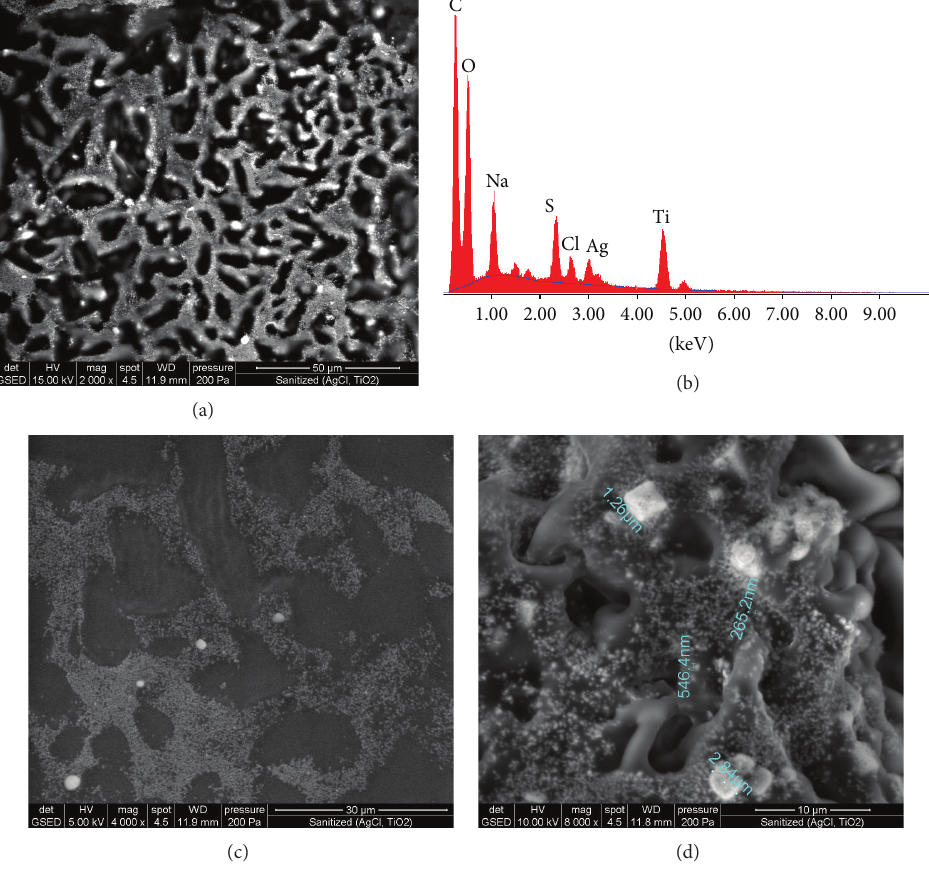
Figure 1: SEM and EDAX images for colloidal solution of silver chloride and titanium dioxide sanitized T 27-22 silver: (a) SEM image for colloidal solution at resolution × 2000, (b) EDAX image for colloidal solution, (c) SEM image for colloidal solution at resolution × 4000, and (d) SEM image for colloidal solution at resolution ×